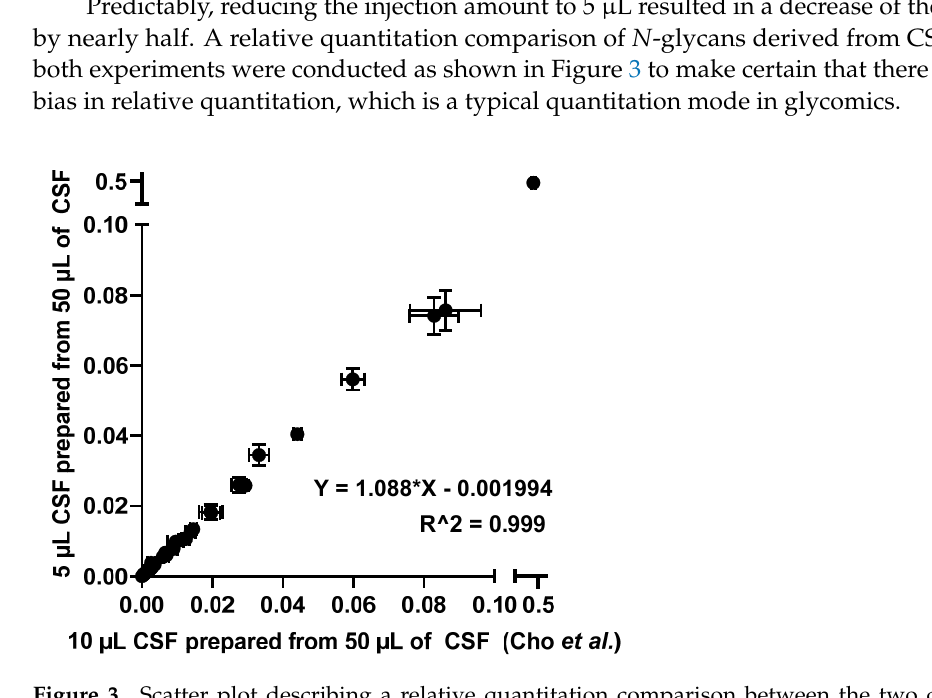
Figure 3. Scatter plot describing a relative quantitation comparison between the two different injection amounts.